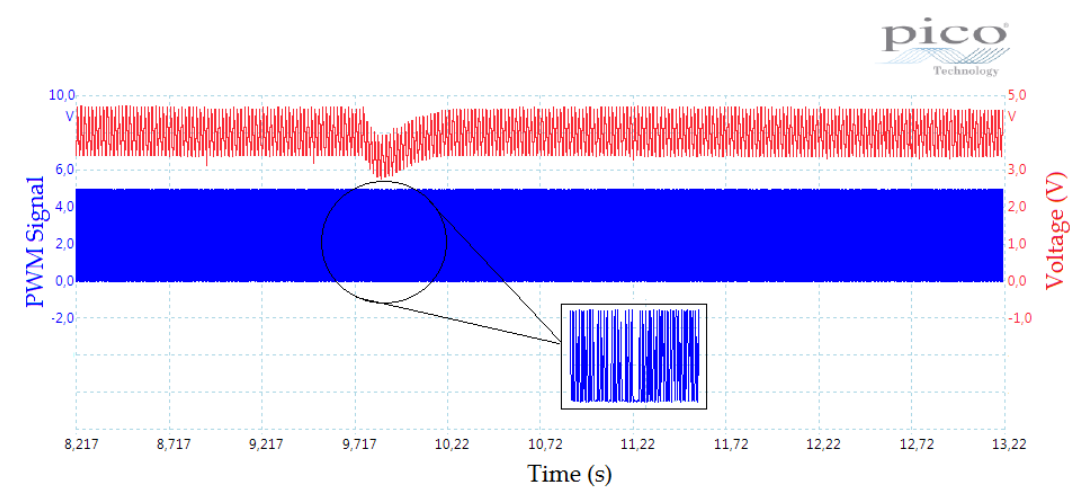
Figure 19. Control signal (blue) by using the hysteresis MPPT algorithm and PV voltage